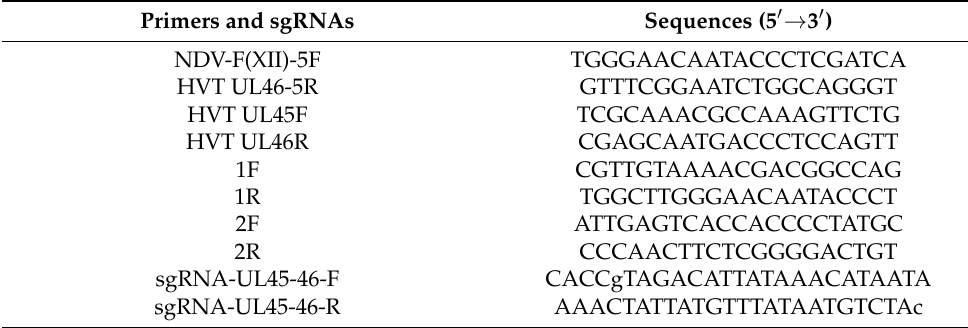
Table 1. A list of the primer sequences used in this study. Primers and